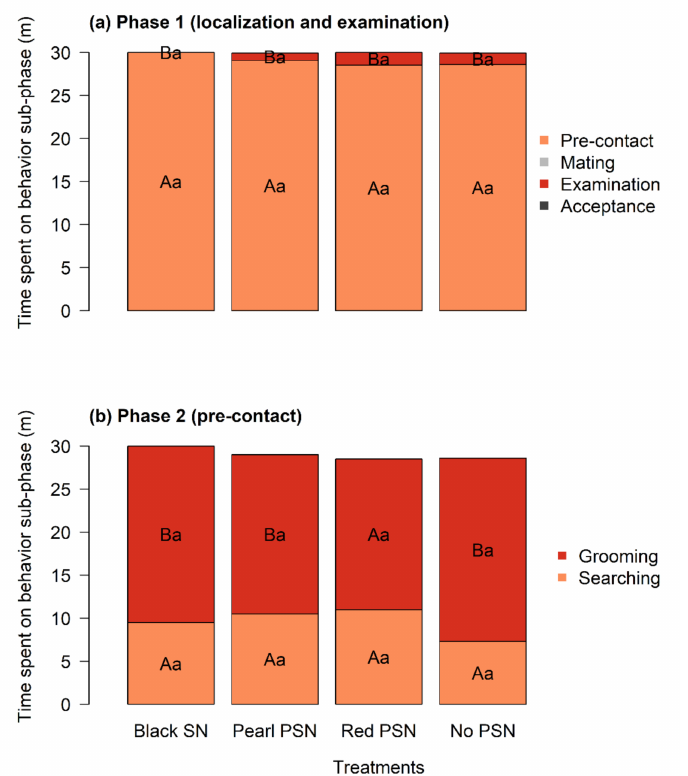
Figure 3. Effects of the PSN and black SN on the mean time (minutes) allocated by M. ridens females to the different behavior categories: ( a ) phase 1 (localization and examination): (1.1) pre-contact, (1.2) mating, (1.3) examination, and (1.4) acceptance *; ( b ) phase 2 (pre-contact): (2.1) searching and (2.2) grooming. The total observation time was 30 min. Different lowercase letters in bars indicate significant differences among treatments for each sub-phase according to the Kruskal–Wallis test. Uppercase letters in bars indicate significant differences among sub-phases within each treatment according to the Wilcoxon signed-rank test for paired observations. Time spent by M. ridens females on the mating sub-phases and acceptance of phase 1 were so low that they are not shown in the